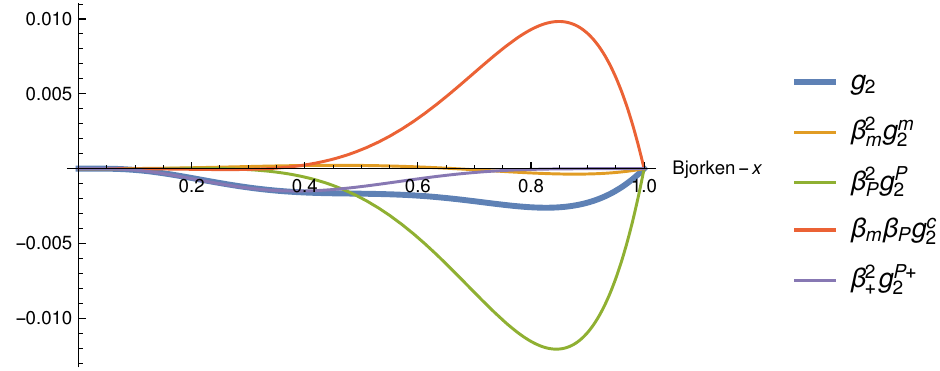
Figure 5 . The full structure function g 2 (blue line) as a function of the Bjorken parameter x , obtained from the contribution of the twist-3 spin-1/2 fermionic operator the curves is analogous as describe in figure 3.